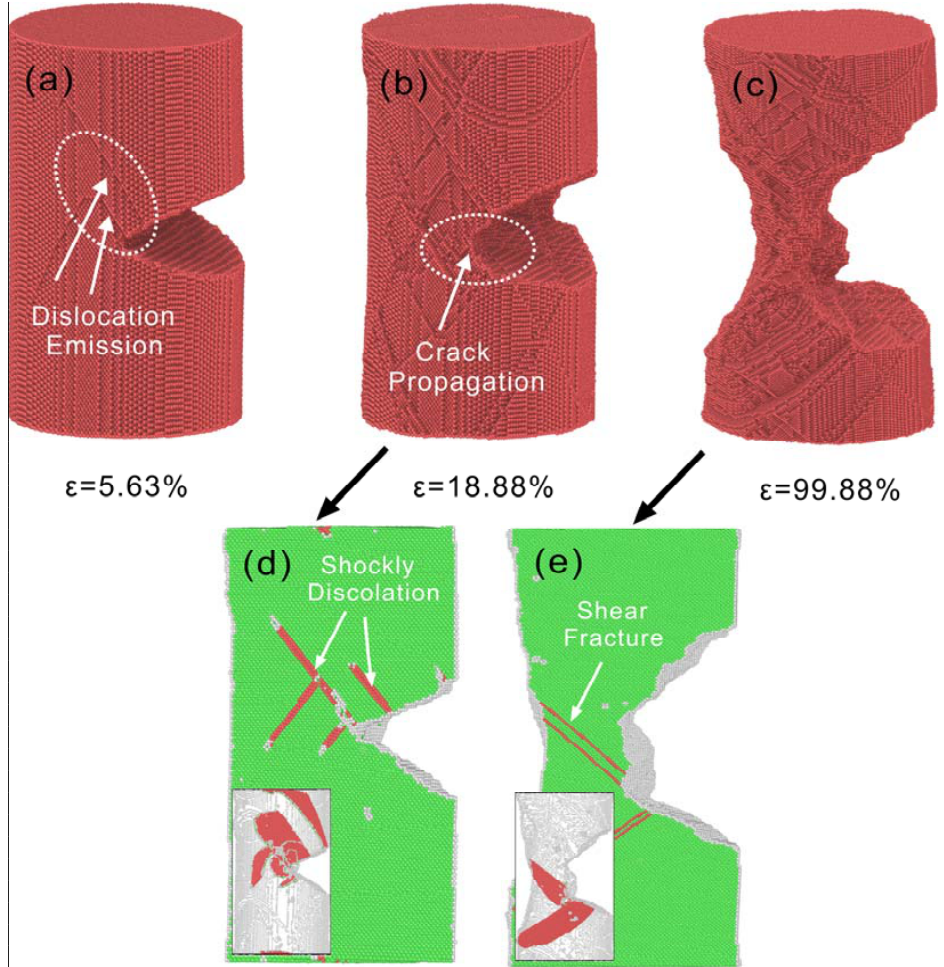
Figure 6. Atomic con fi guration of 75 Å crack depth Cu nanowires at strain rate 5 (cid:3400) 10 (cid:2876) s (cid:2879)(cid:2869) . ( a ) ε = 5.63%, ( b ) ε = 18.88%, ( c ) ε = 99.88%, ( d , e ) are the atomic con fi gurations of ( b , c ) after CSP and DXA analysis, respectively.